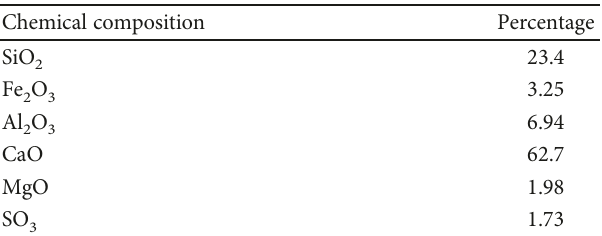
Table 1: Chemical composition of cement used in this study, determined by X-ray fl uorescence